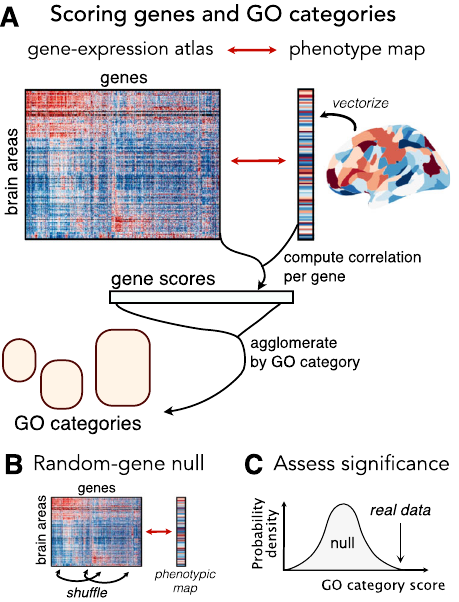
Fig. 1 Pipeline for applying gene category enrichment analysis (GCEA) to brain-wide expression atlas data. A Given a phenotype map, we fi rst compute the spatial correlation coef fi cient between that map and each gene. These gene scores are then agglomerated at the level of categories using an annotation system like the Gene Ontology (GO). For continuous scores, agglomeration is typically performed as the mean score of genes annotated to a category. B Statistical signi fi cance of a GO category is assessed relative to the random-gene null, which estimates a null distribution for each GO category by annotating genes to GO categories at random. C For every GO category, a p value is estimated using a permutation test, by comparing the GO category score obtained from the real data to the null